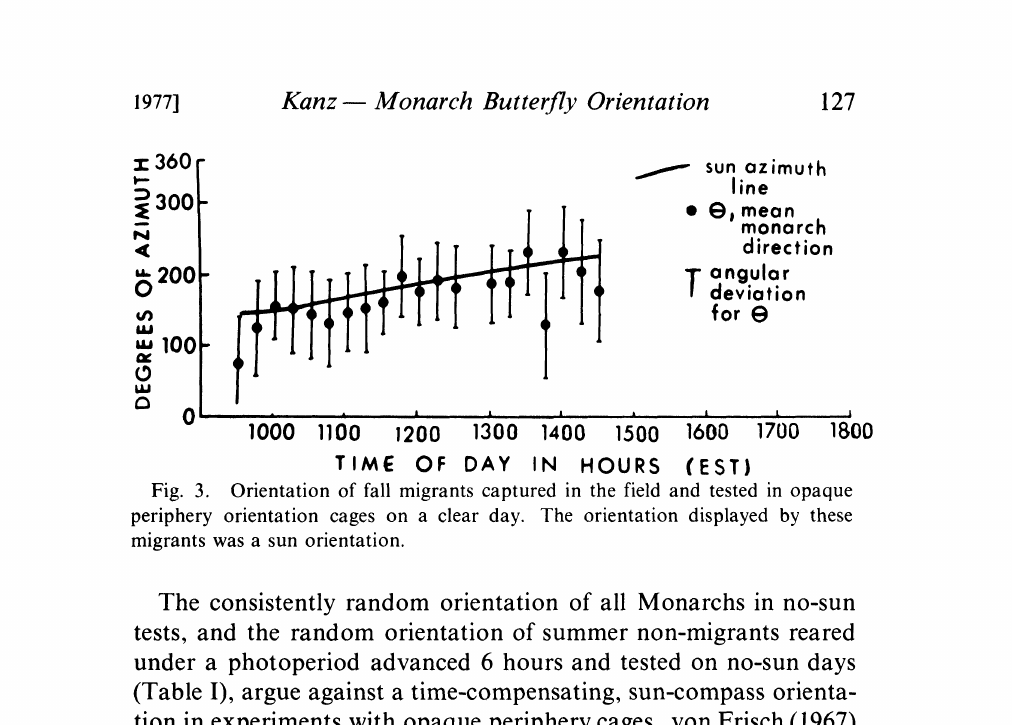
Fig. 3. Orientation of tall migrants captured in the field and tested in opaque periphery orientation cages on a clear day. The orientation displayed by these migrants was a sun